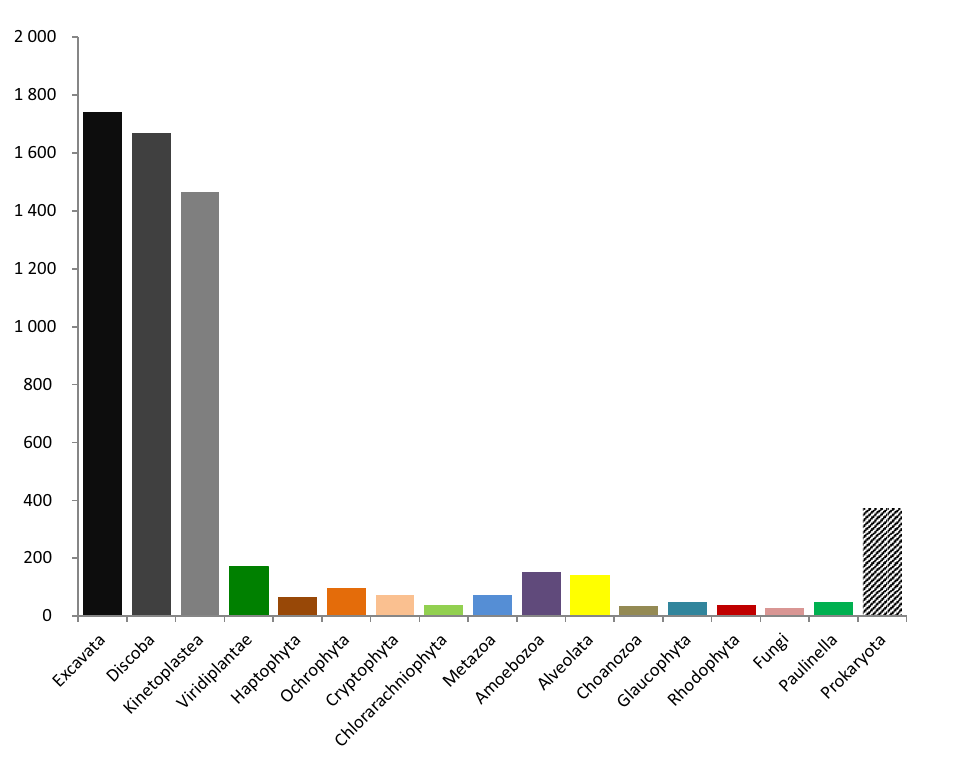
Figure 3. Graph summarising taxonomical affinities of the predicted proteins of Rhabdomonas costata . 3,129 protein phylogenies, in which R. costata was robustly (BS ≥ 75) placed into a taxonomically homogeneous clan, were sorted accordingly into taxonomic bins. Discoba and Kinetoplastea represent the subgroups of Excavata.